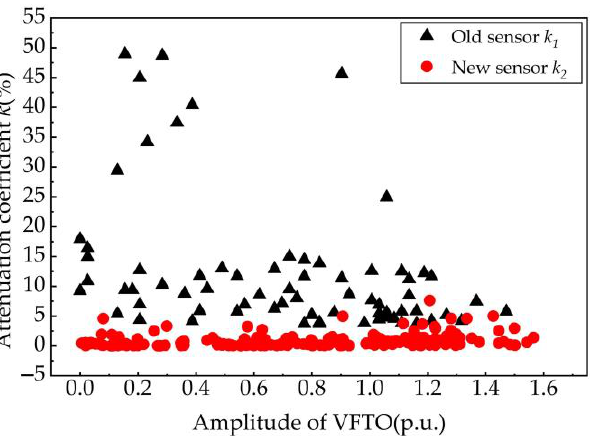
Figure 15. Attenuation proportional coefficient of trapped charge voltage component in measurement results of the new signal conditioning sensor and the old impedance converter.